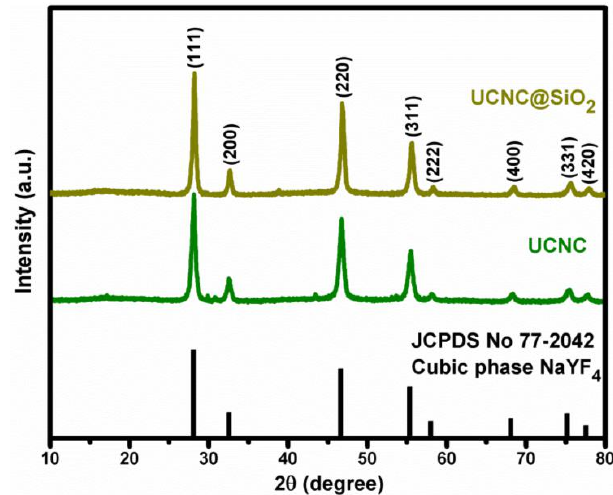
Figure 1. Powder X-ray diffraction pattern of upconversion nanocrystals (UCNC) and UCNC@SiO 2 .